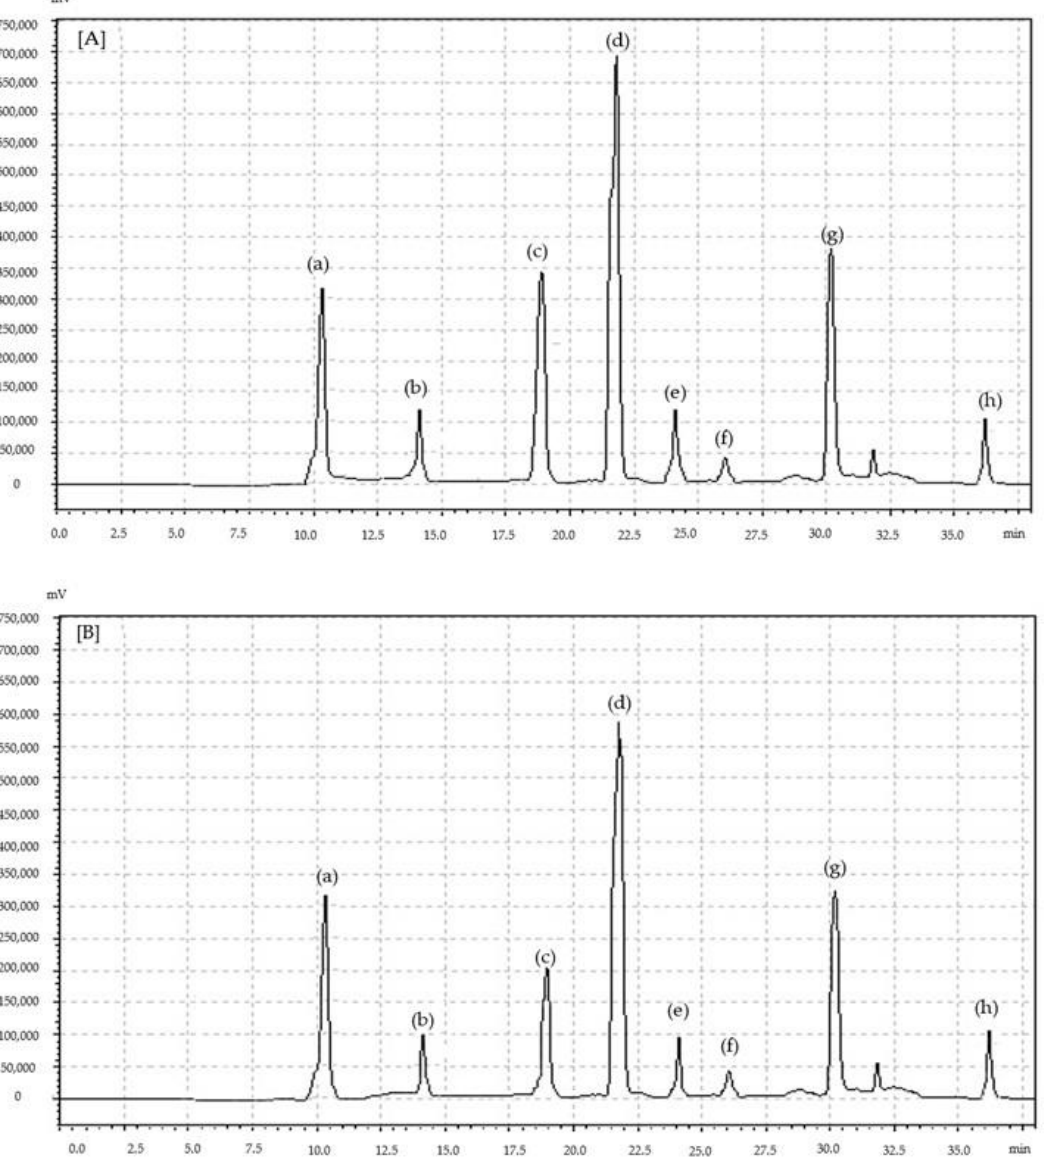
Figure 2. Chromatograms showing retention times for polyphenols (phenolic acids and flavonoids) in organic ( A ) and conventional ( B ) blackcurrant; ( a ) chlorogenic, ( b ) caffeic, ( c ) quercetin-3-O-rutinoside, ( d ) ferulic acid, ( e ) kaempferol-3-O-glucoside, ( f ) myricetin, ( g ) quercetin-3-O-glucoside, ( h ) kaempferol.